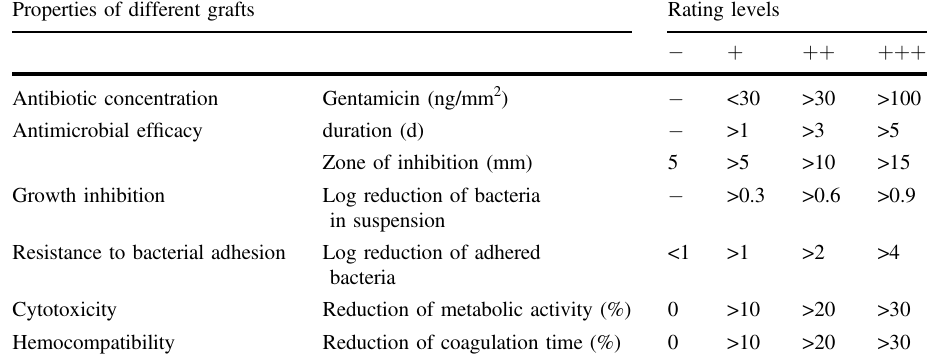
Properties of different